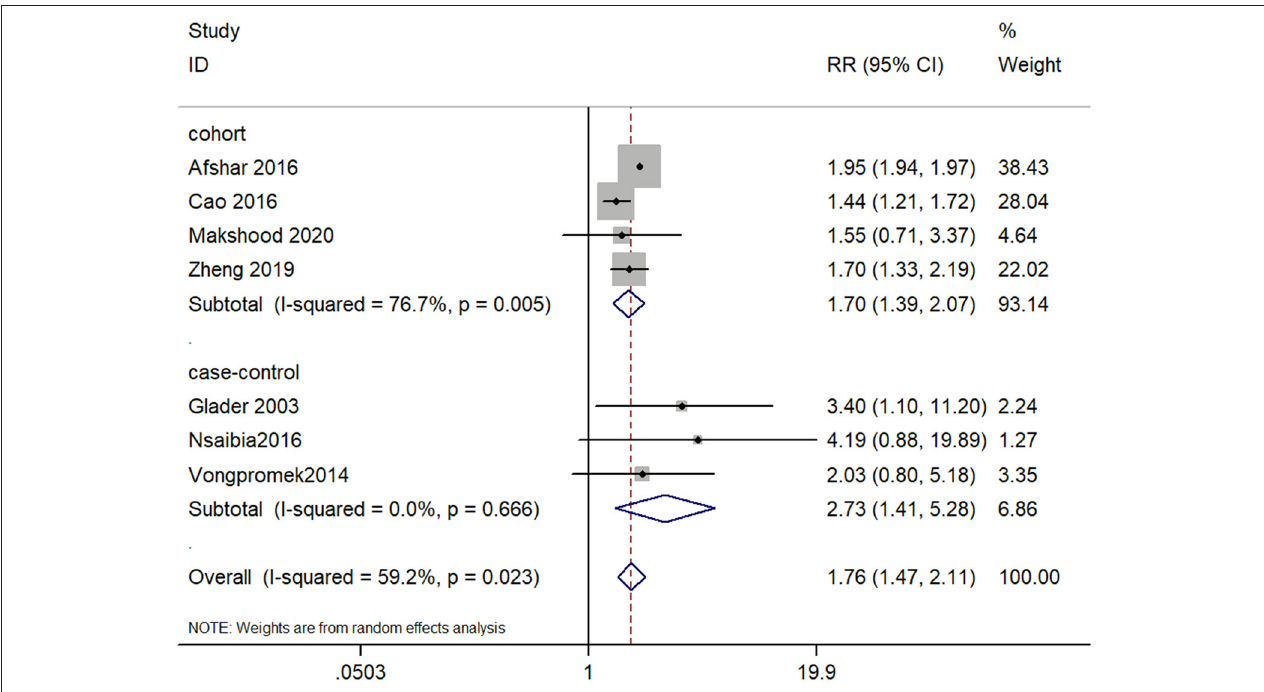
FIGURE 2 | Forest plot for examining the association between lp(a) ≤ 50 mg/dL and CAVD.